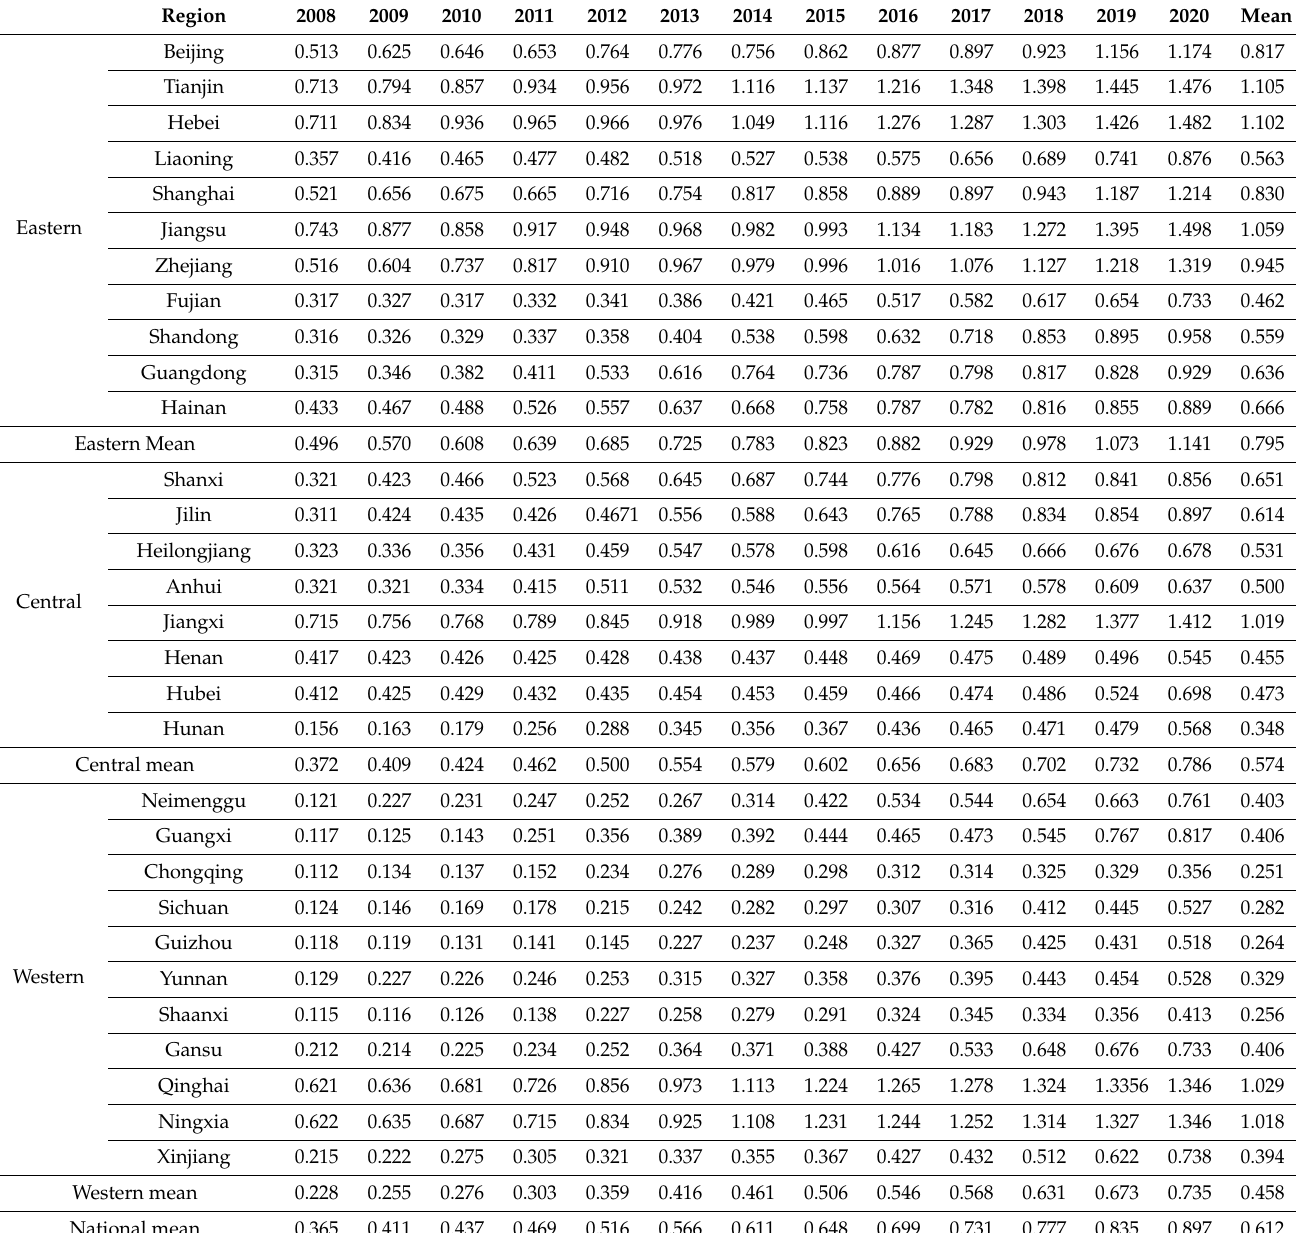
Table 3. Calculation results of transportation industry